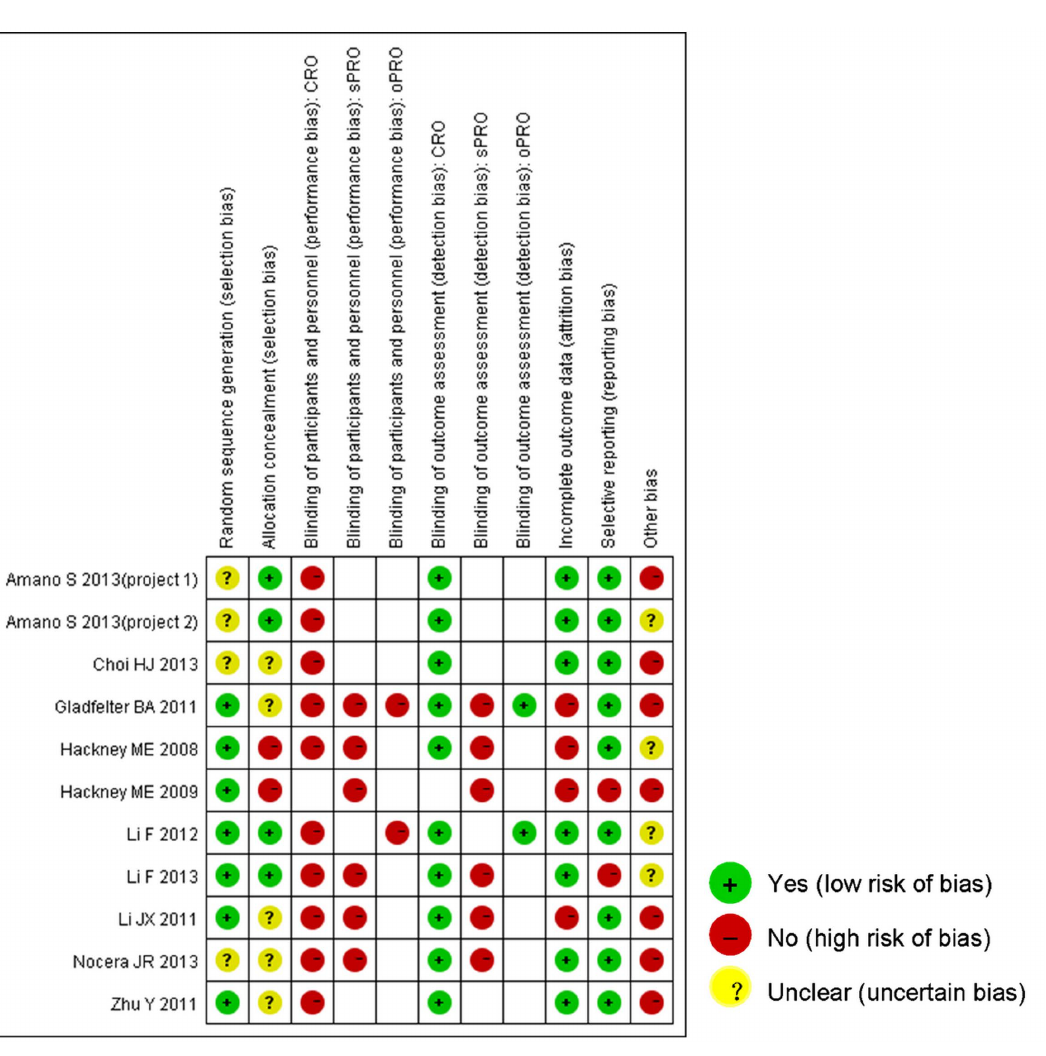
Figure 2. Risk of bias summary. The article [33] reported two independent trials that are labeled as project 1 and 2. Blank entries mean that the outcome was not reported. CRO, clinician-reported outcome; sPRO, subjective patient-reported outcome; oPRO, objective patient-reported outcome.